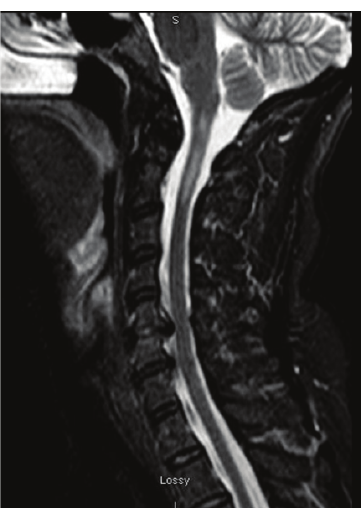
Figure 2: MRI cervical spine T2 sagittal sequence showed a hyperintensity extending from C1 to